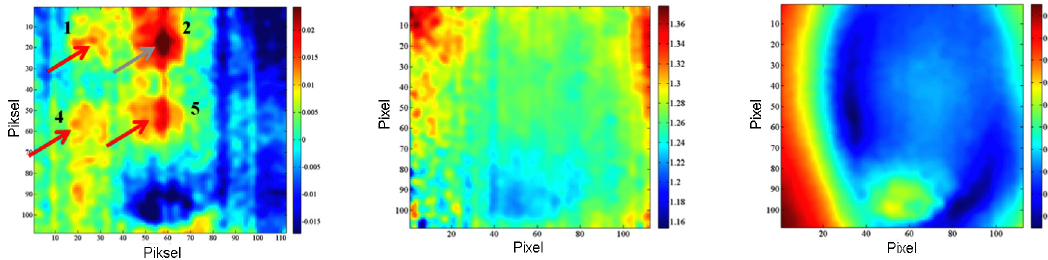
Fig. 9. PCT (EOF 5 ), BM 3-2, bottom surface, distance 1.5 m